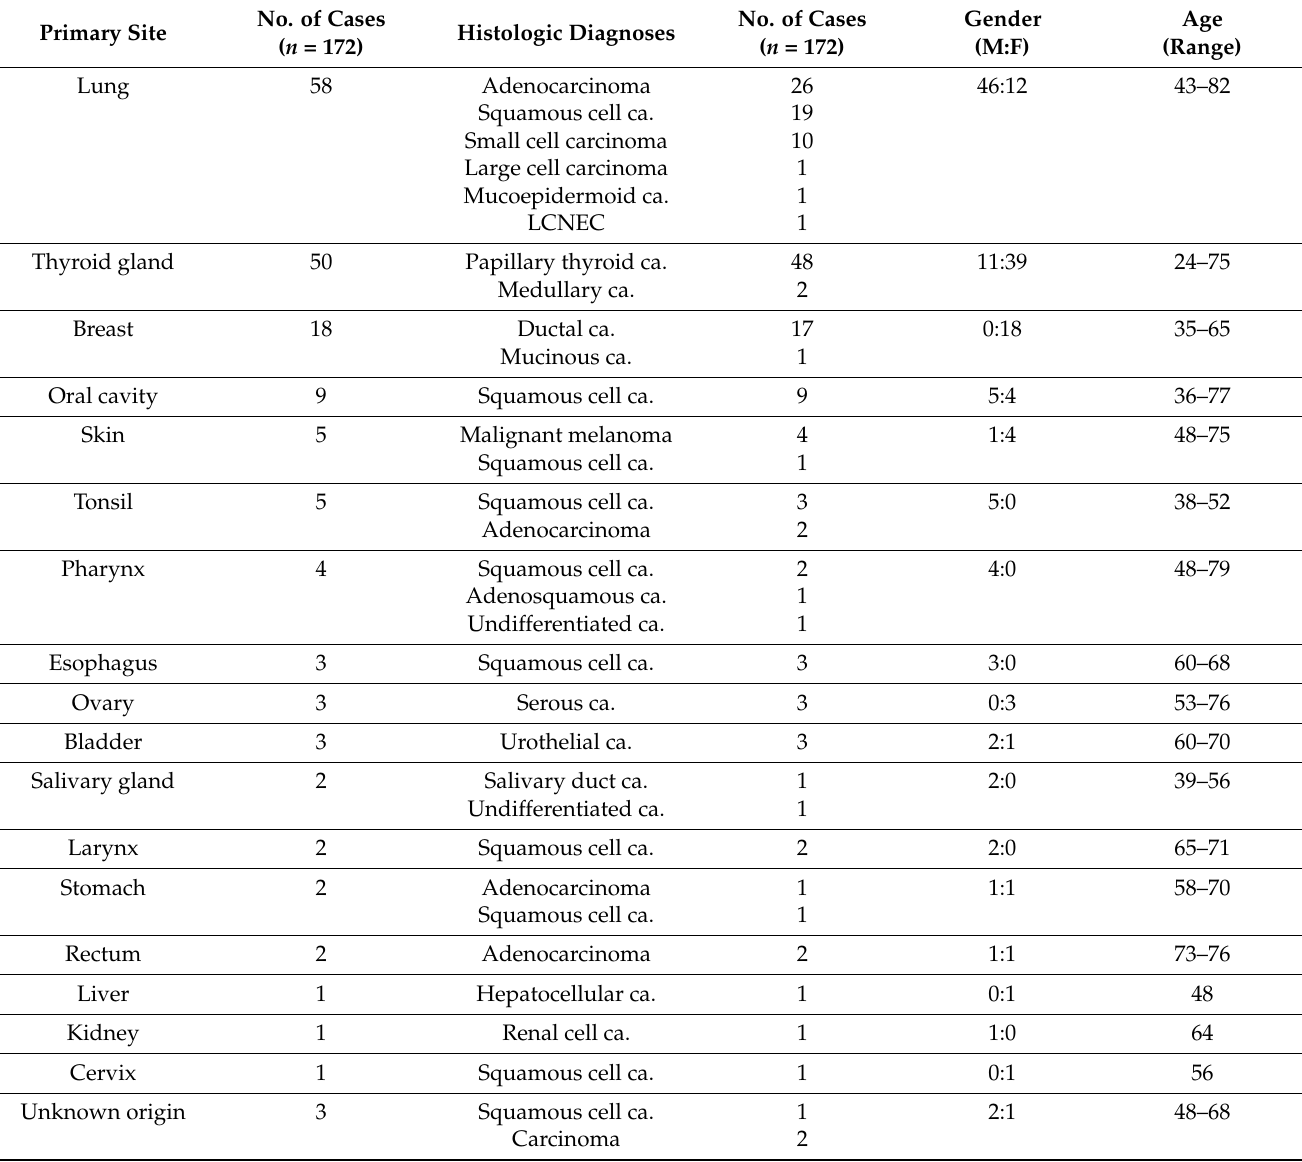
Table 3. Distribution of primary sites of the metastatic tumor in lymph